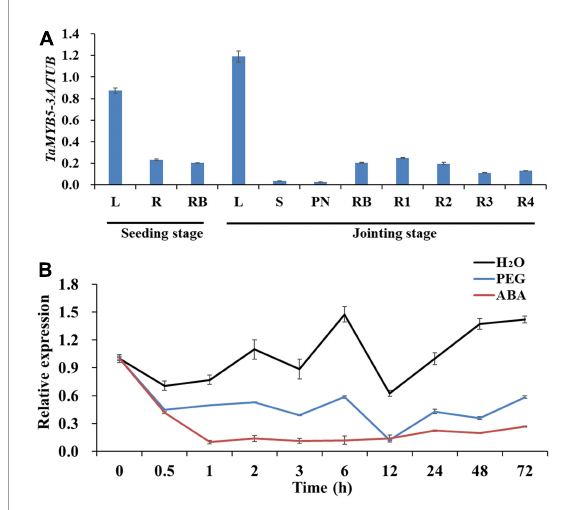
FIGURE6 Expression patterns of TaMYB5 in wheat. (A) Expression patterns of TaMYB5-3A in different plant tissues at seedling and jointing stage. L, leaf; S, stem; PN, penultimate node; RB, root base; R1, R2, R3, and R4 indicate the root section from the ground to 30, 30–60, 60–90, and 90–120 cm depth, respectively. (B) Relative expression of TaMYB5-3A following H 2 O (Control), PEG, and ABA treatment. Two-week-old seedlings of Hanxuan 10 were treated with PEG-6000 and 50 µ M ABA. Leaves were collected for expression experiments. All data are the means ± SE of three independent